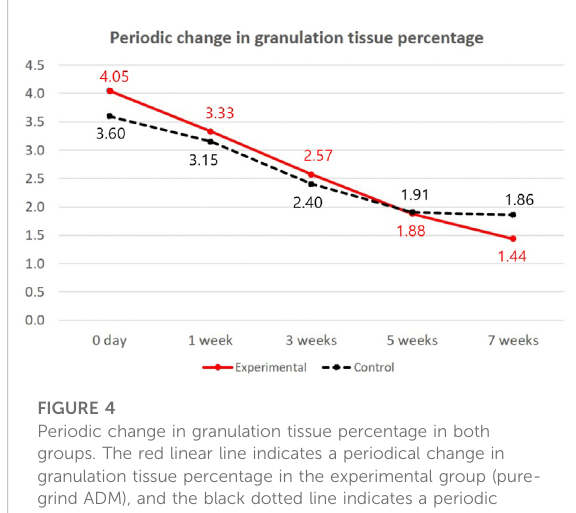
FIGURE 3 Periodic changes in wound depth grade in both groups. The red linear line indicates a periodical change in wound depth grade in the experimental group (pure-grind ADM), and the black dotted line indicates a periodic change in wound depth grade in the control group.